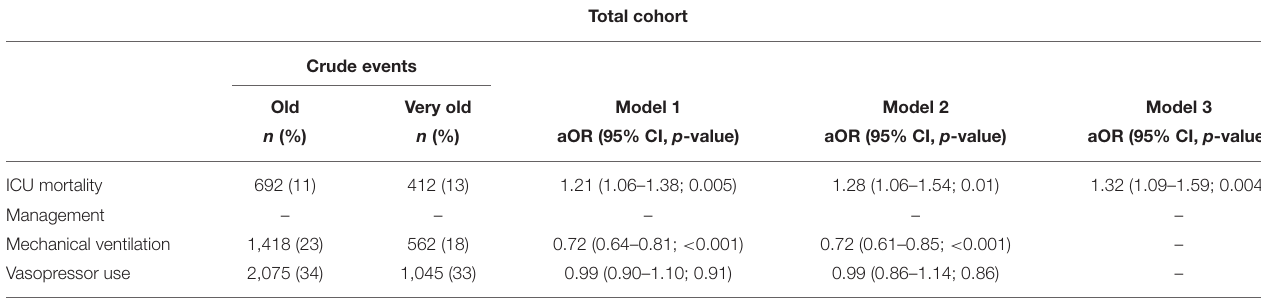
TABLE 3 | Associations of old vs. very old septic patients with mortality and management strategies in three multi-level logistic regression